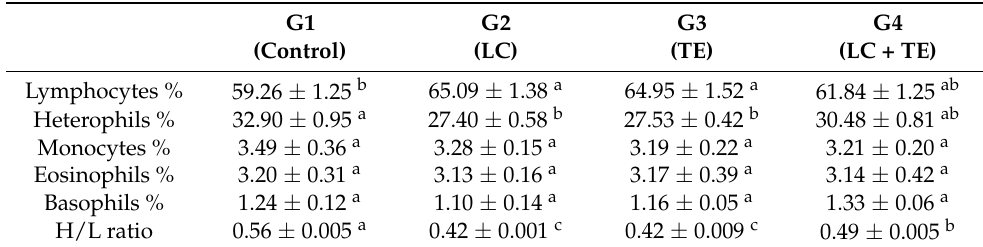
Table 3. Effect L-Carnitine and/or calf thymus extract supplementation on differential leukocytic count % in Japanese quail (mean ± SE), n =